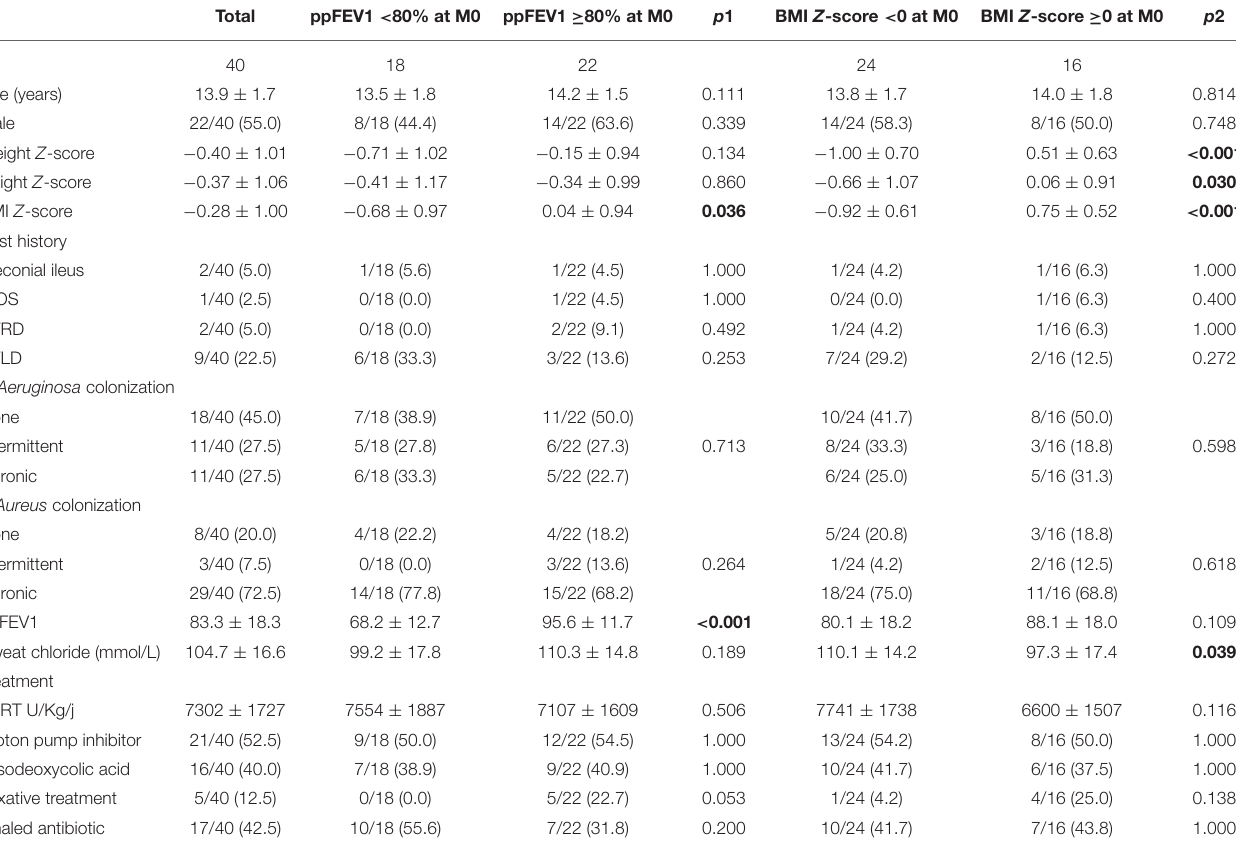
TABLE 1 | Characteristics of patients at lumacaftor/ivacaftor